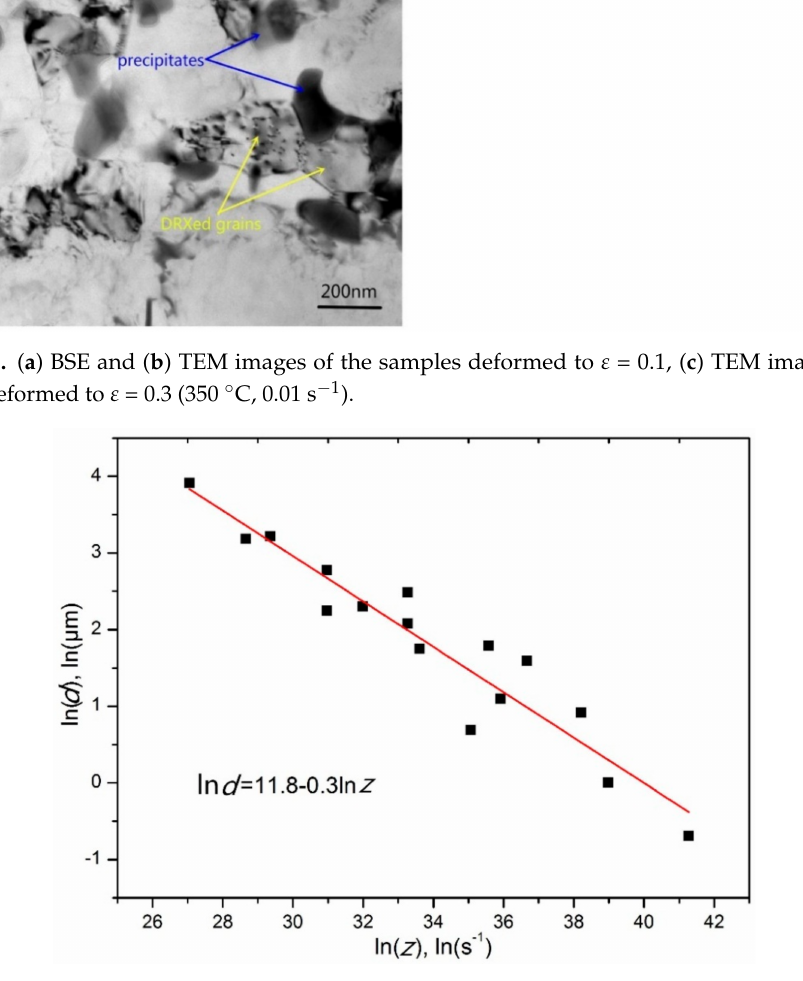
Figure 12. Plots for the relationship between the resulting grain size and Zener – Holloman